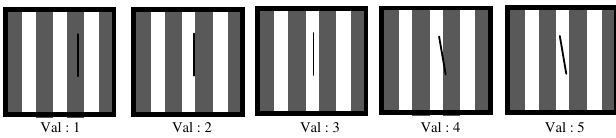
Fig. 16. Value for the “local impact” attribute – law of simi- larity and law of